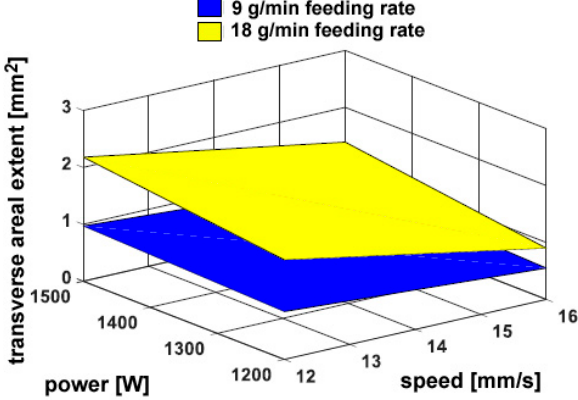
Figure 12. Transverse extent of reported metal A h as a function of the governing variables; edge deposition.